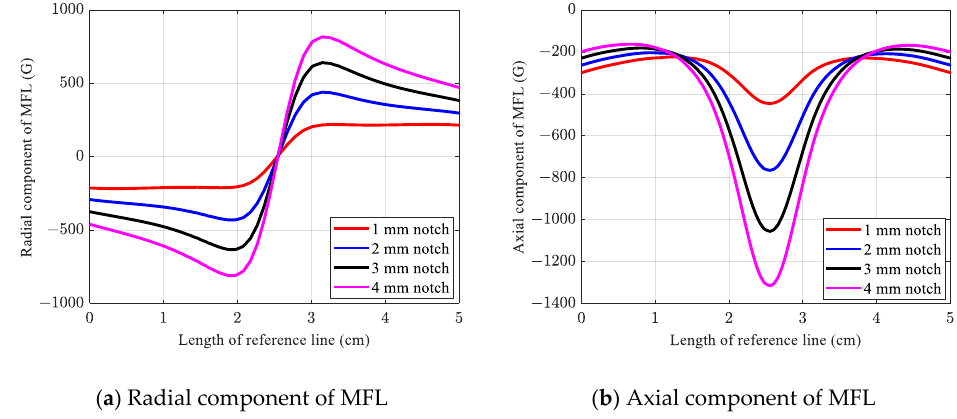
Figure 7. MFL signal obtained from the conventional numerical simulation.